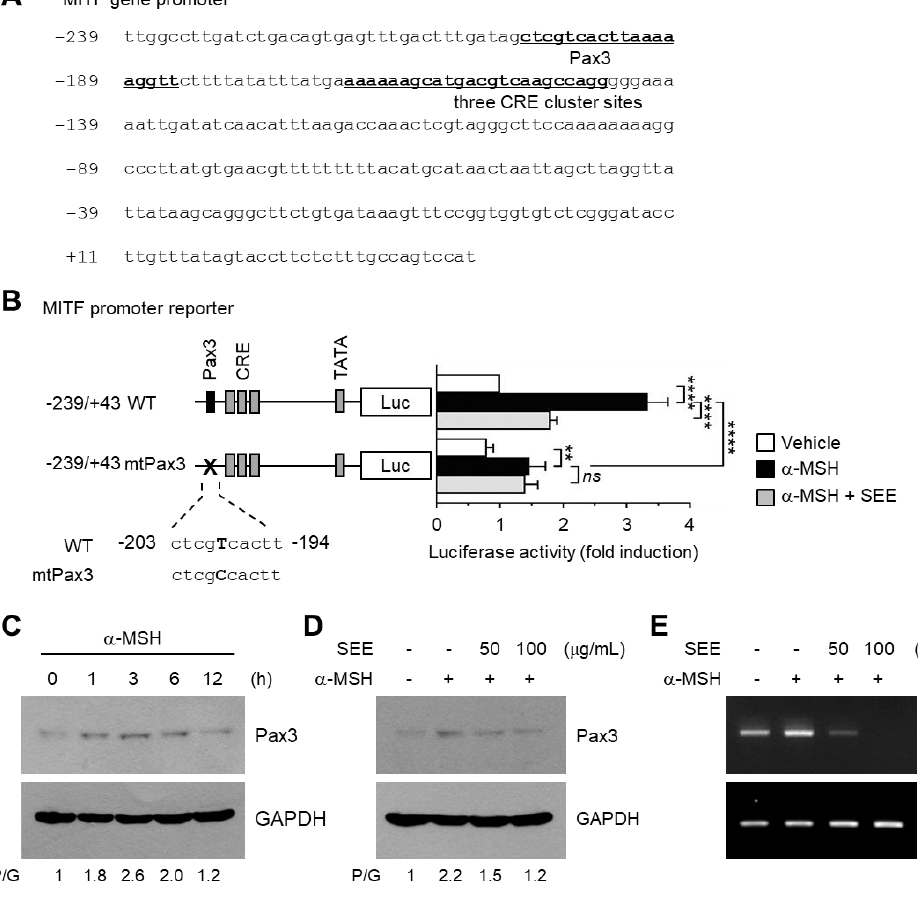
Figure 5. Effect of SEE on the inhibition of α -MSH-induced MITF promoter activity via suppression of Pax3. ( A ) DNA sequence of the proximal promoter region of the MITF gene. The putative Pax3 and cAMP response element (CRE) cluster sites are underlined. The transcription start site is designated as +1. ( B ) B16F10 cells were transfected with 0.2 µ g of a wild-type (WT) or site-specific mutant for Pax3 (mtPax3) derived from − 239/+43 construct. Forty-eight hours later, the cells were treated with either vehicle (DMSO), 100 nM α -MSH, or α -MSH plus 50 µ g/mL SEE for 8 h, and the luciferase activities were measured. The data shown represent the mean ± SD ( n = 3). **** p < 0.0001; ** p = 0.0020; ns , not significant. ( C ) B16F10 cells were treated with 100 nM α -MSH for various times (0–12 h), and cell lysates were subjected to immunoblotting using antibodies against Pax3. The GAPDH level was examined as an internal control. The intensity of the bands was quantified using ImageJ and the relative Pax3 intensity was normalized to that of GAPDH and visualized in the blot. P/G, Pax3/GAPDH. ( D , E ) B16F10 cells were treated with either vehicle (DMSO) or SEE (50 or 100 µ g/mL) for 30 min, followed by stimulation with 100 nM α -MSH for 3 h. Cell lysates were subjected to immunoblotting using an antibody against Pax3 ( D ), and the total RNA was isolated, and Pax3 mRNA was measured by RT-PCR ( E ). The GAPDH level was examined as an internal control. To determine the possible contribution of the Pax3-binding element in α -MSH-induced MITF transcription, the core sequence of the Pax3-binding motif spanning − 203 to − 194 within the − 239/+43